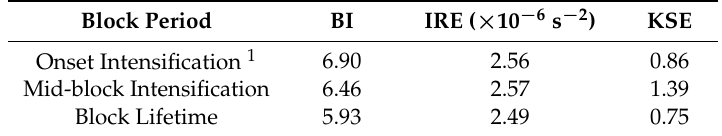
Figure 2. As in Figure 1, except for ( a ) the onset time (1200 UTC 24 February 2017) and ( b ) peak intensity (1200 UTC 4 March 2017). Table 1. Values for Block Intensity (BI), IRE, and Kolmogorov Smirnov Entropy ( KSE) during the lifecycle of the winter 2014 blocking event studied here, and the onset period as well as the mid-life intensification. The units for IRE are shown and BI and KSE are without units.